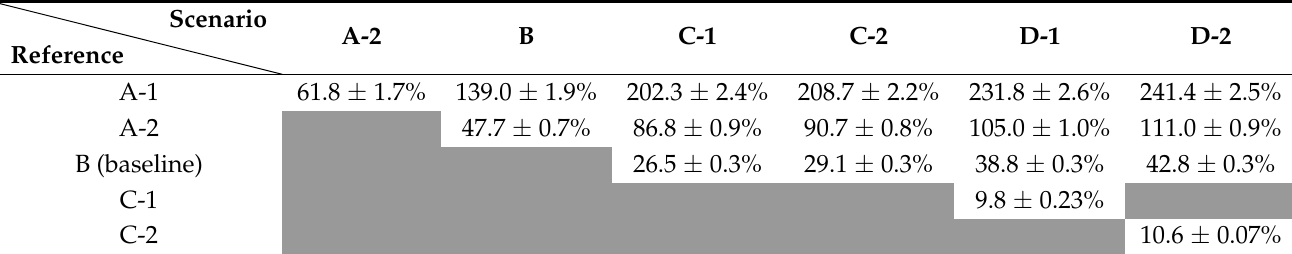
Table 4. Overhead of our trace collection solution for high-throughput write workloads in Cassandra. The overhead of our solution compared to the baseline is below 27% when using the snapshot mode in LTTng and around 29% when using the standard